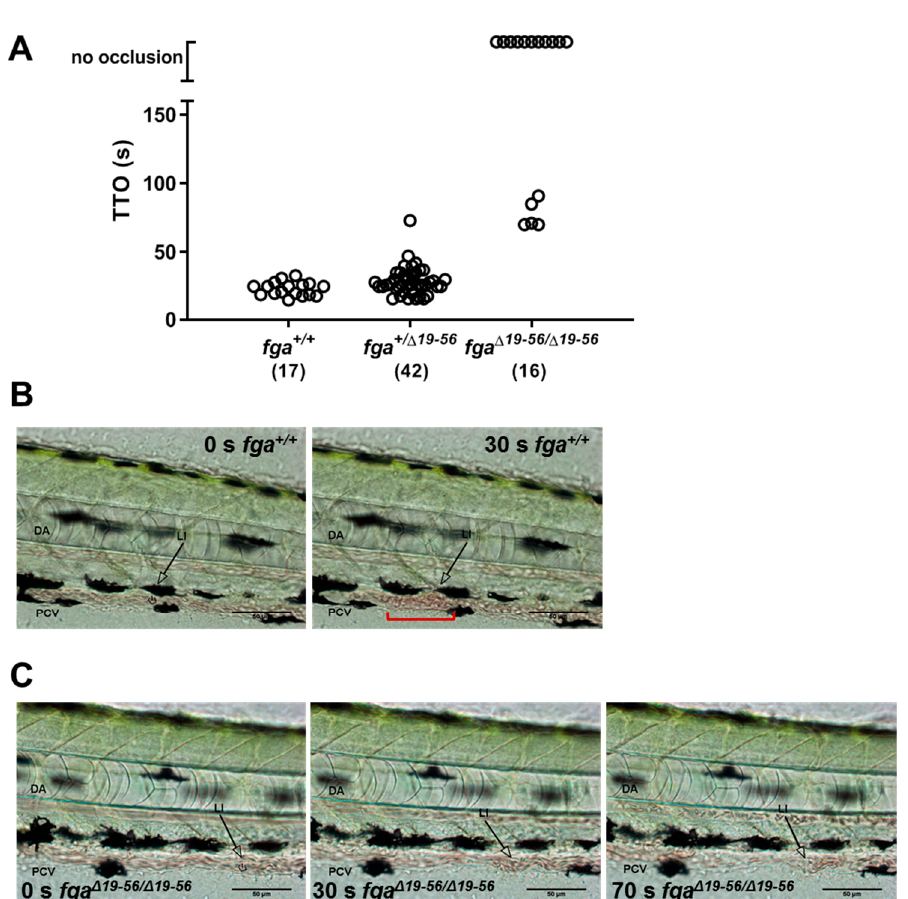
Figure 5. Laser-induced venous thrombosis in a hypodysfibrinogenemia model. ( A ) TTO for 3 dpf fga +/+ , fga +/ Δ 19 − 56 and fga Δ 19 − 56/ Δ 19 − 56 larvae. Each circle represents one larva. The number of larvae tested in each group is shown in brackets. ( B , C ) Time lapse images of fga +/+ and fga Δ 19 − 56/ Δ 19 − 56 larvae upon (0 s) or 30 s after injury. The dorsal aorta (DA), posterior cardinal vein (PCV) and site of laser injury (LI) are indicated. An arrow marks the laser target. A red bracket in the right panel of B highlights the region of thrombus